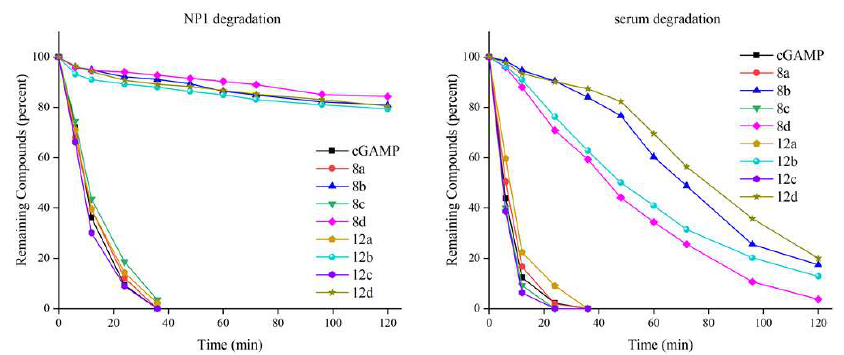
Figure 4. Enzymatic cleavage resistance assays. The cGAMP analogs were incubated with nuclease P1 or serum for 2h; the remaining amount was determined by HPLC and calculated by the peak area.